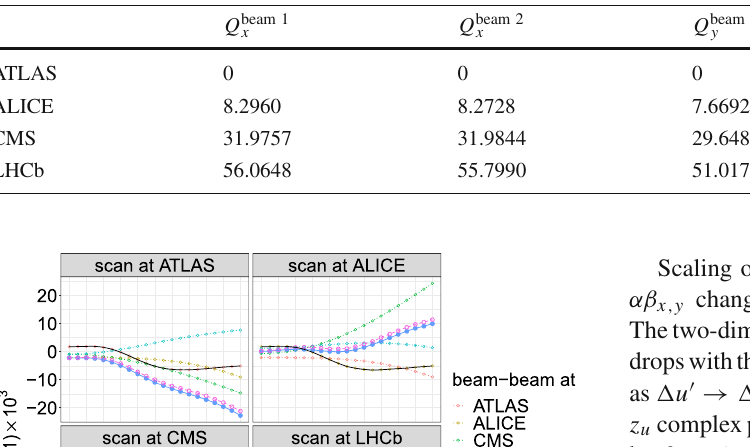
Table 2 The phase advances Q i x , y defined in (3.24) for two LHC beams in x and y directions with respect to ATLAS in Run 2 proton–proton van √ s = 13 TeV. Last column lists the beta-functions β x = β y from [24] used in Fig. 8 simulation der Meer scans at